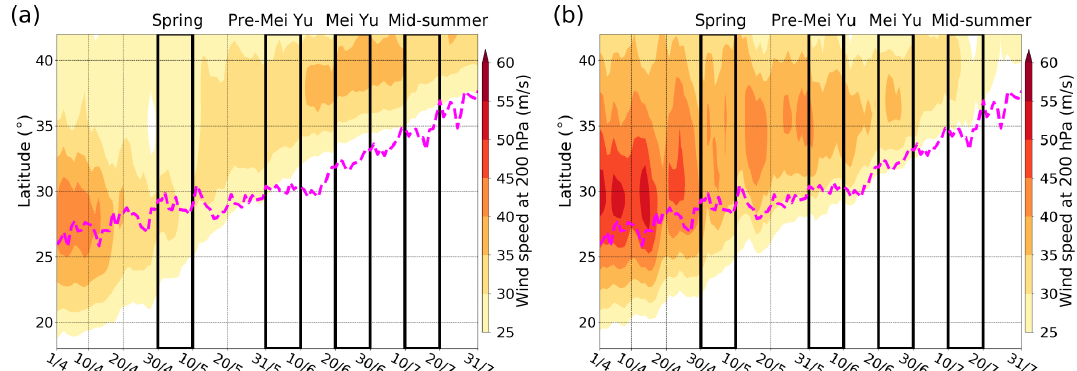
Figure 7. Hovmöller plots of wind speed at 200hPa (ms − 1 ) averaged between (a) 80–100 ◦ E and (b) 110–120 ◦ E. The dashed magenta line indicates the daily latitude of the EASMF at 850hPa, averaged between 110–120 ◦ E. The dekads representing the four stages of EASM progression (bold black lines) are selected according to Fig. 3. Data from ERA5 1979–2018 climatology.